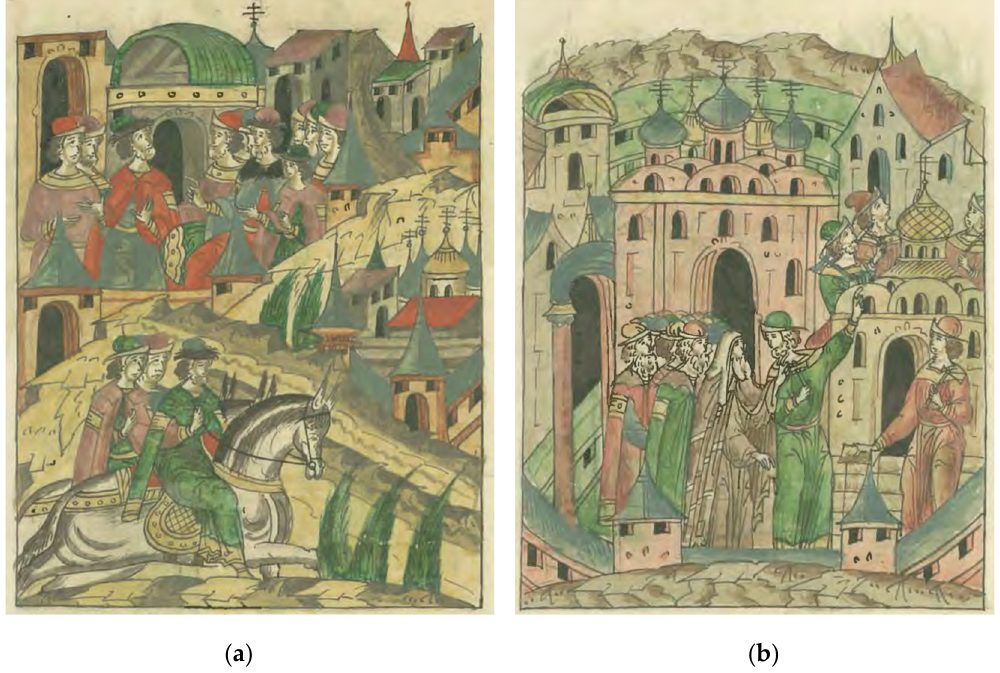
Figure 8. Powerful figures of the North. ( a ) Prince Konstantin, 1419; ( b ) Vladyka Ioan building a stone church, 1411. The Illustrated Chronicle of Ivan the Terrible, Osterman Volume II . Library of the Russian Academy of Sciences.